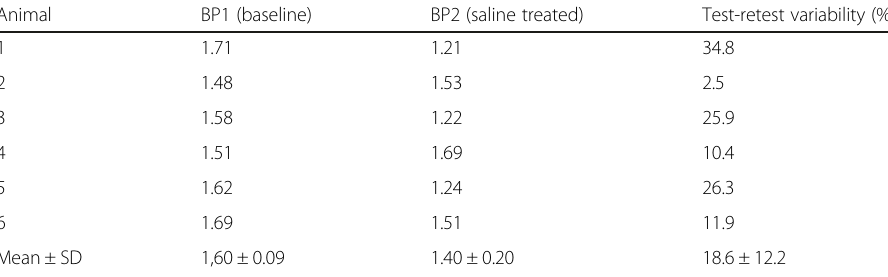
Table 2 Test-retest statistics for [ 18 F]JNJ42259152 in rat striatum Animal BP1 (baseline) BP2 (saline treated) Test-retest variability (%)